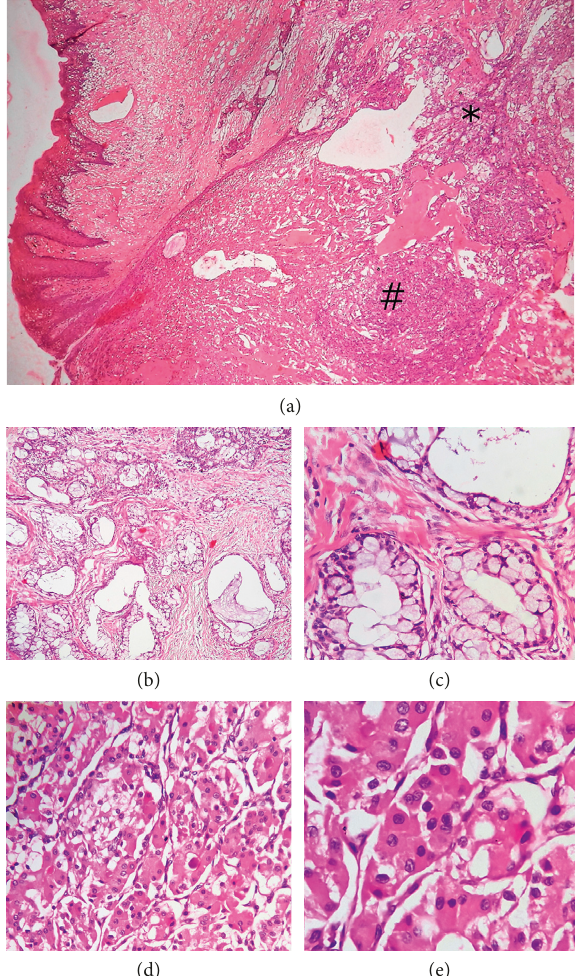
Figure 2: (a) Low-power view showing neoplastic glandular epi- thelial cells ( ∗ ) separated from the overlying mucosal parakeratinized stratified squamous epithelium. Oncocytic cells (#) intermixed with the cellular elements of mucous, epidermoid, and intermediate cells (magnification 4x). (b) Tumour mass showing multiple large cystic spaces (magnification 10x). (c) Cystic spaces lined by mucous cells (magnification 40x). (d) Oncocytic metaplasia evidenced by the presence of oncocytes (magnification 10x). (e) Cells with granular eosinophilic cytoplasm arranged in an organoid/alveolar pattern and supported by thin fibrous connective tissue septa (magnification